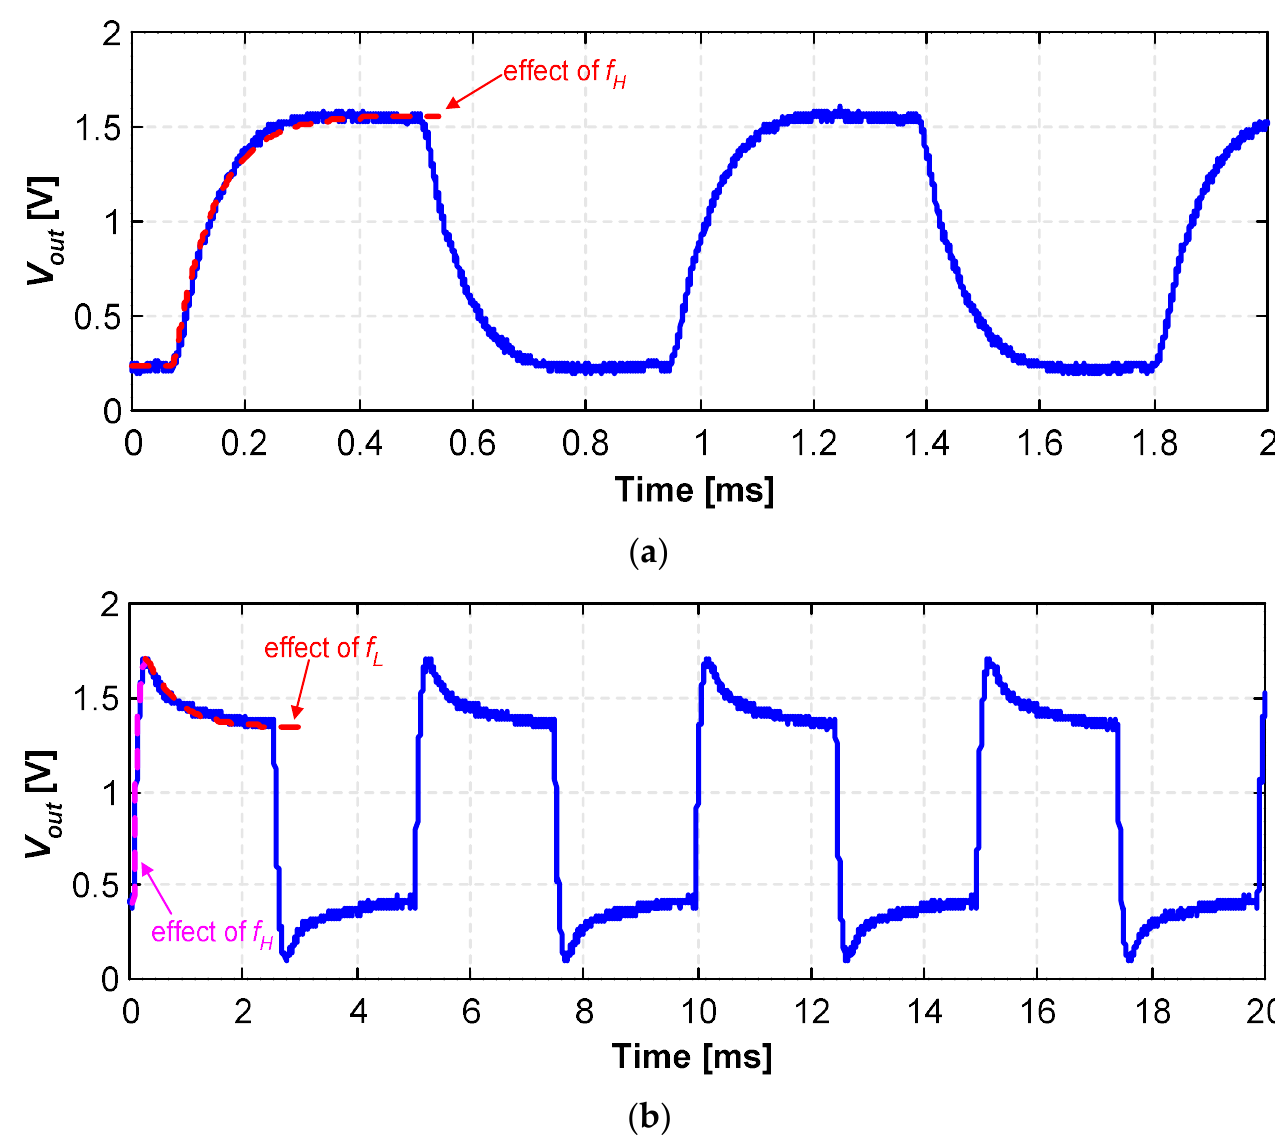
Figure 15. LNA response for input waves with square shape, amplitude of 20 mV and frequencies of ( a ) 1.15 kHz and ( b ) 200 Hz.